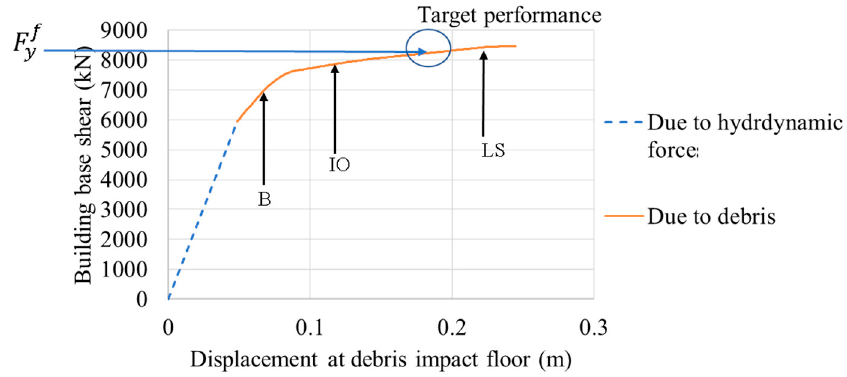
Figure 23. Target performance based on the selected fender yield force.